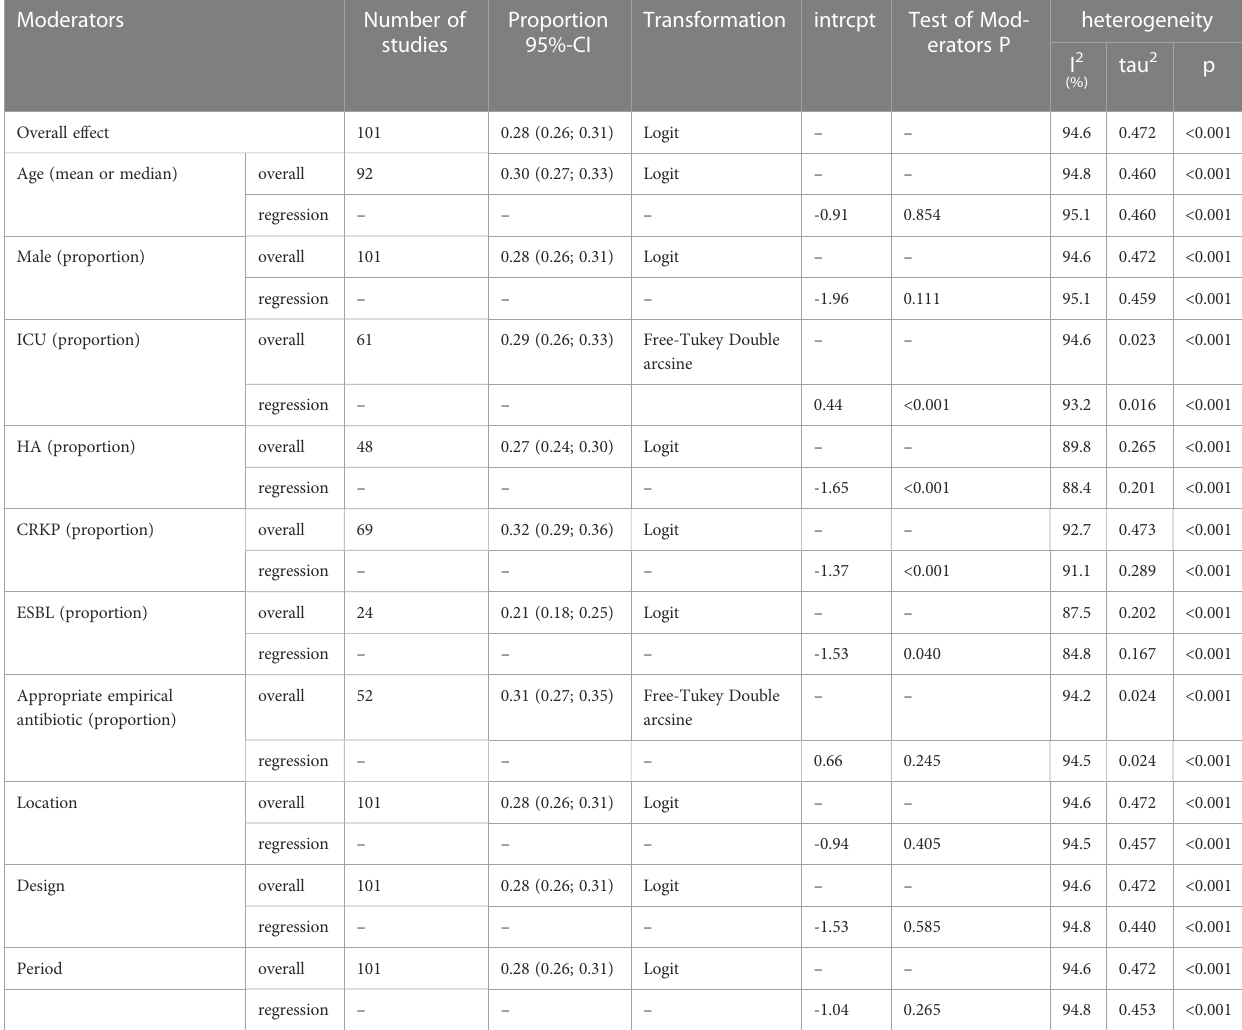
TABLE 1 Meta-regression results of single proportion of 30-day mortality for KPB.